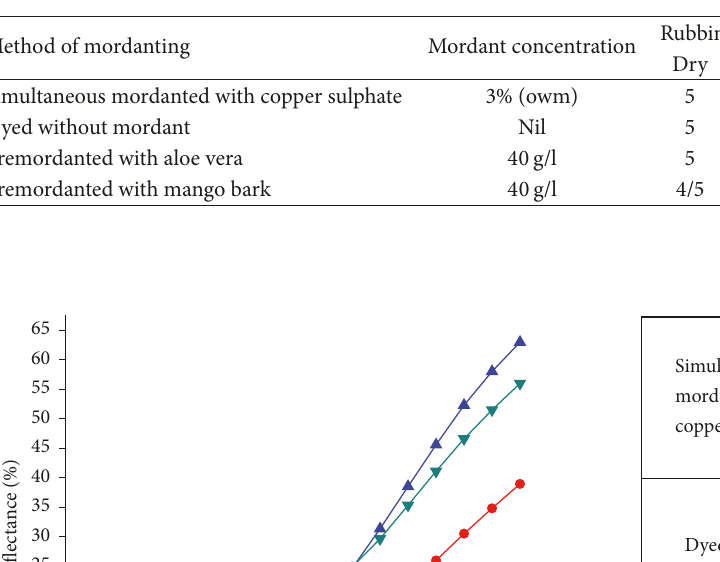
Table 4: Color fastness properties of dyed leather samples.